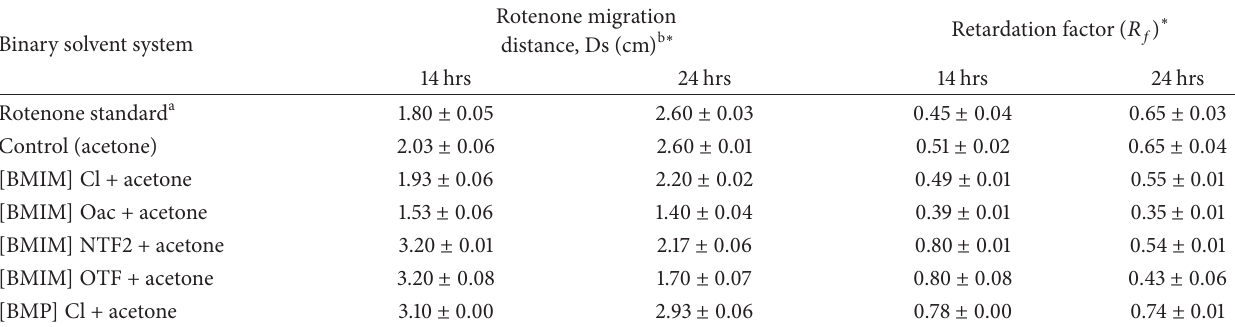
Table 2: Qualitative analysis of rotenone via TLC on varies binary solvent systems.